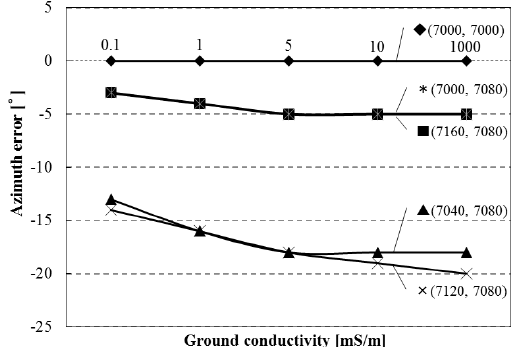
Figure 9. Azimuth errors as a function of ground conductivity when the conducting structure is located at (7000 m, 7000 m), (7000 m, 7080 m), (7040 m, 7080 m), (7120 m, 7080 m), and (7160 m, 7080 m).